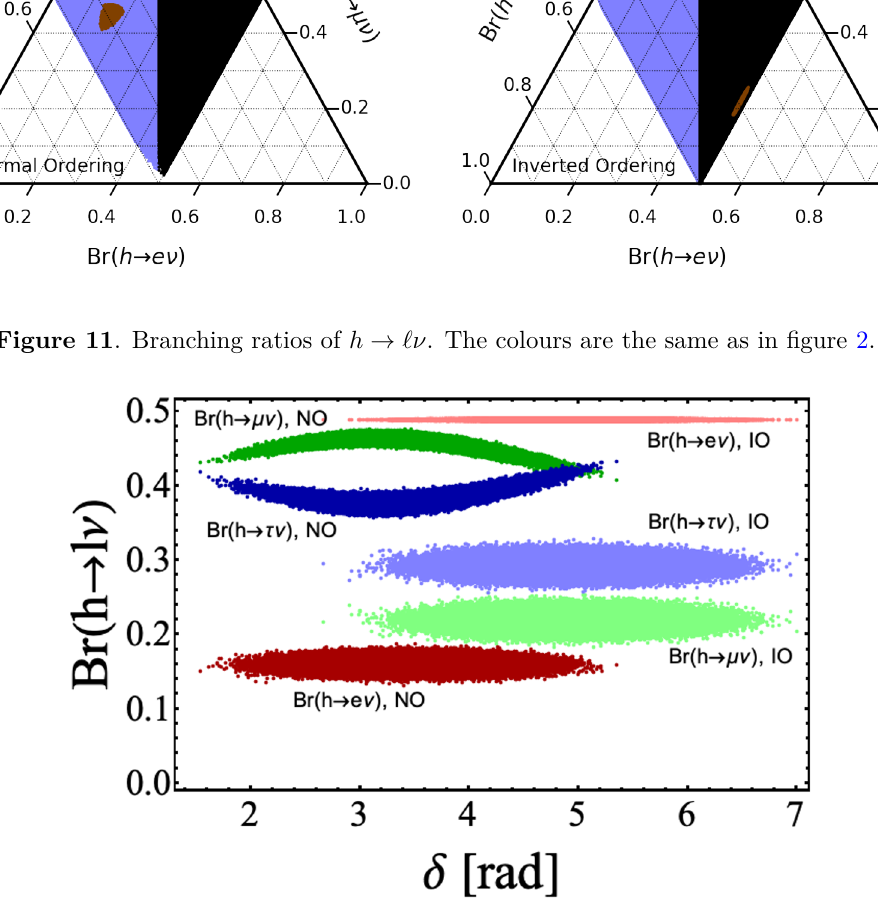
Figure 12 . Branching ratios of the different channels h → ‘ν as functions of the Dirac CP phase δ in the quadratic case (Case